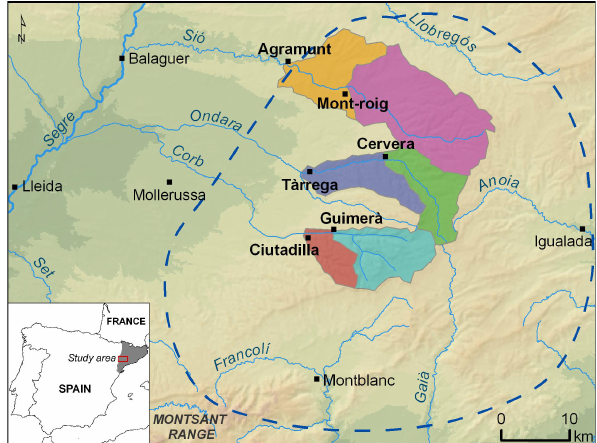
Fig. 1. Map of the area in Western Catalonia (NE Spain) affected by Santa Tecla’s rainstorm in 1874 (blue dashed line), with the three river basins tributaries of the Segre River and the six towns consid- ered in the reconstruction of the event.